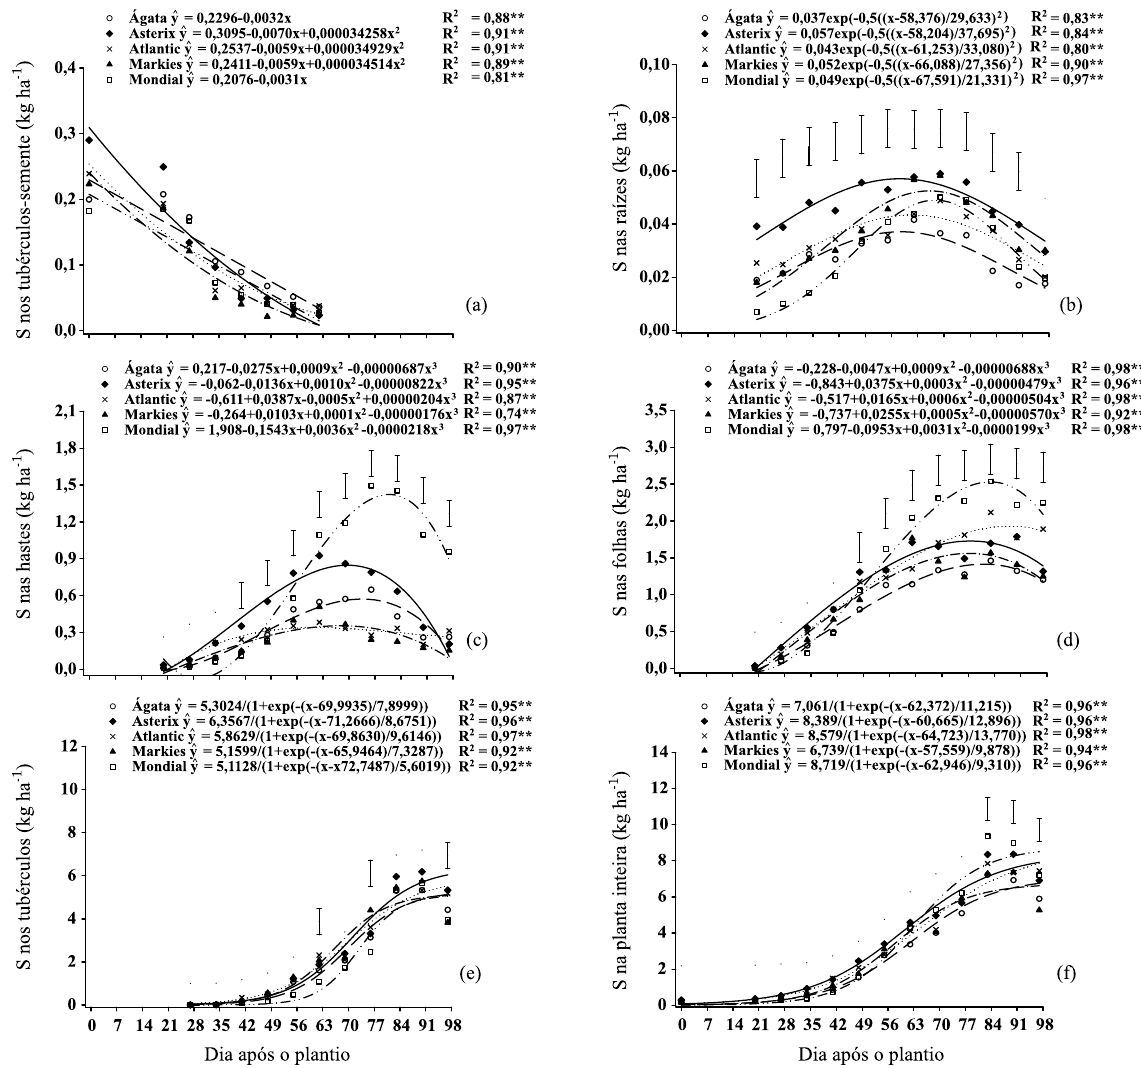
Figura 7. Quantidade total de S nos tubérculos-semente (a), raízes (b), hastes (c), folhas (d), tubérculos (e) e na planta inteira (f) de cultivares de batata ao longo do ciclo. ** significativo a 1 % pelo teste F. Barras verticais indicam o valor de DMS pelo teste de Tukey a 5